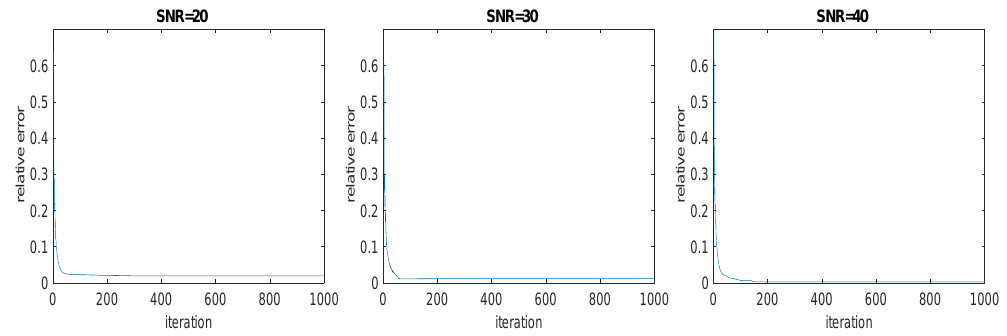
Figure 9. Relative error as a function of iteration number for DC1 with different noise levels. From left to right: SNR = 20 dB, SNR = 30 dB, and SNR = 40